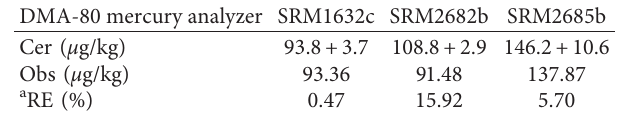
Table 6: Certified (Cer) and observed (Obs) value of mercury in NIST standard reference coal samples.